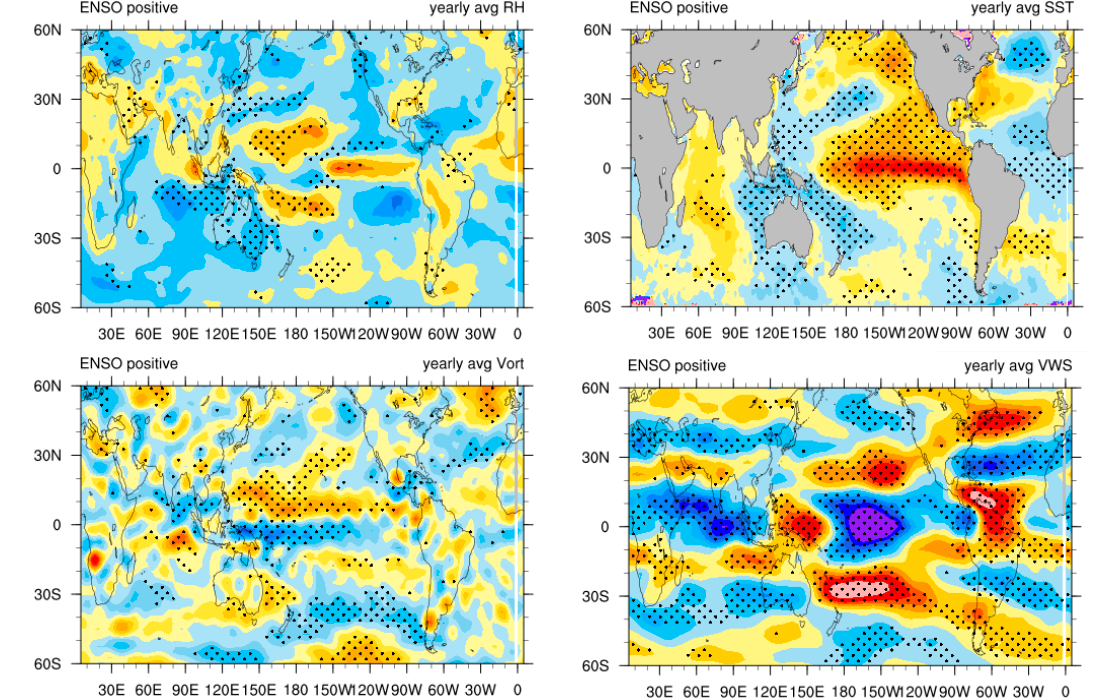
Figure 6. Relative humidity, sea surface temperature, vorticities, and vertical wind shear anomalies during ENSO positive/La Niña phase. Blue (Yellow, Red, and Pink) shade represents negative (positive) units. Dot points indicate >5% significance level.